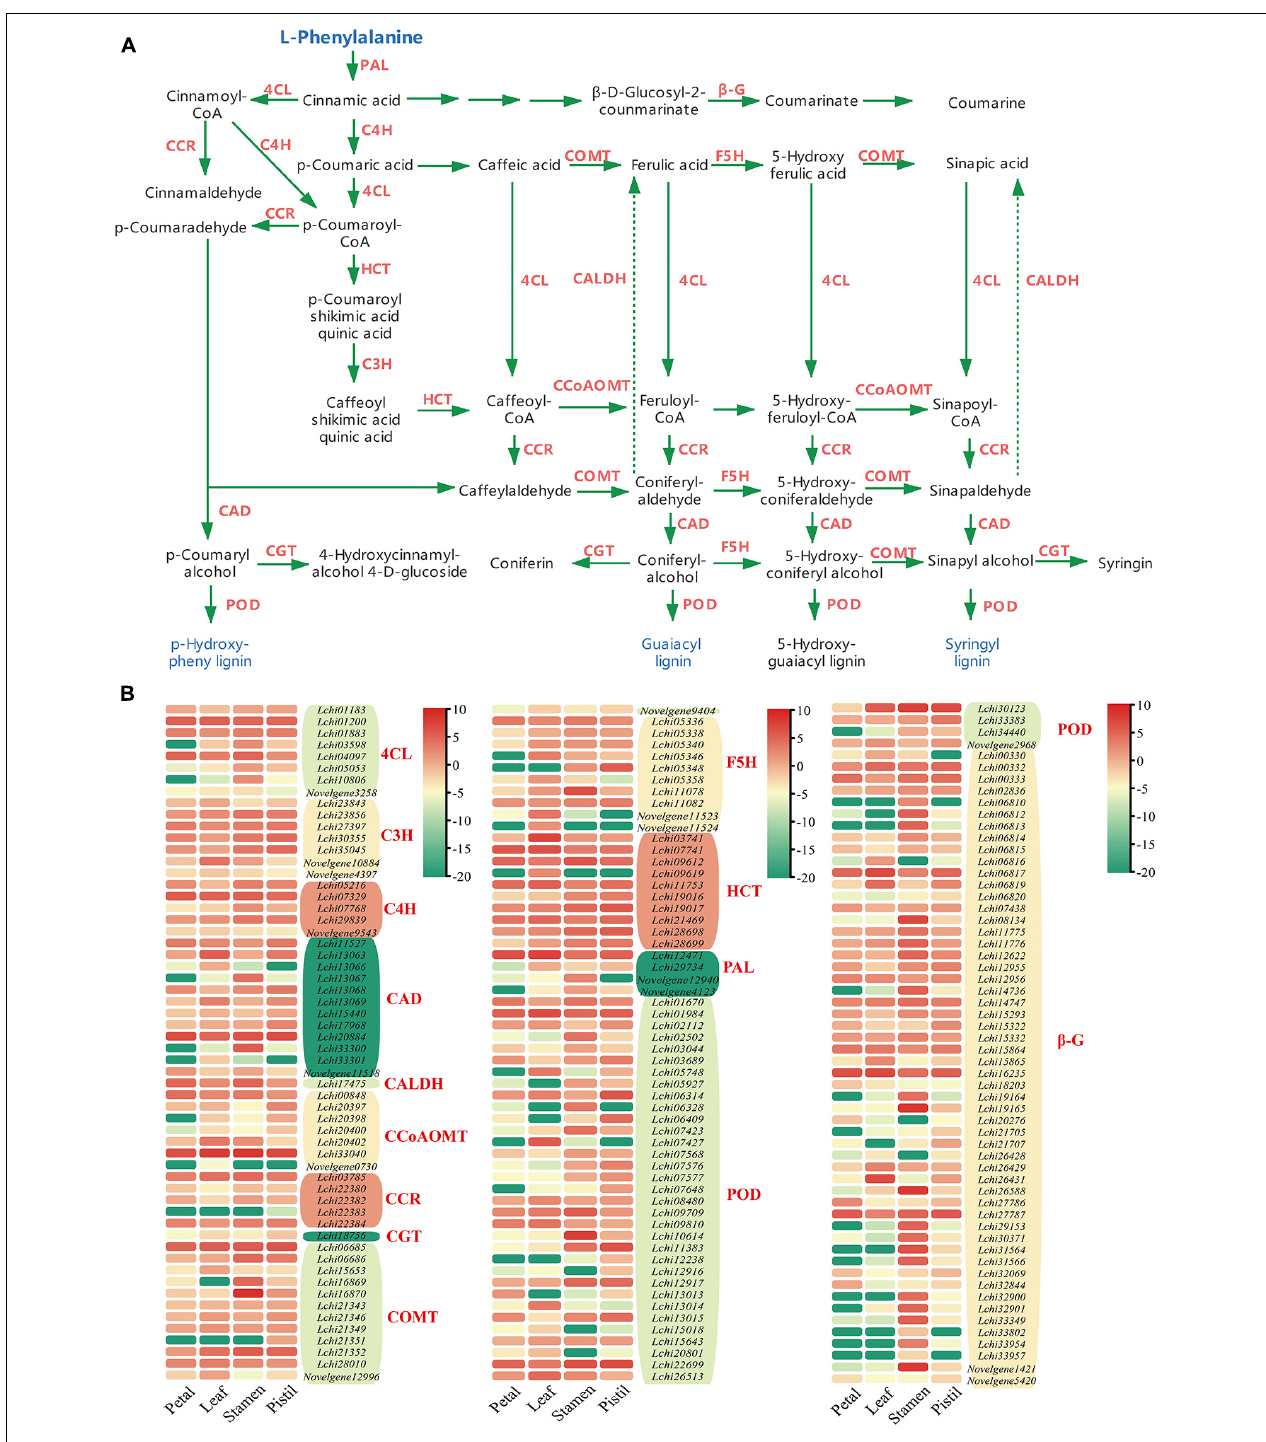
FIGURE 2 | The phenylpropanoid biosynthesis pathway and phenylpropanoid biosynthesis related DEGs in L. chinense . (A) Phenylpropanoid biosynthesis pathway in L. chinense . β -G, beta-glucosidase; 4CL, 4-coumarate-CoA ligase; C4H, cinnamate-4-hydroxylase; C3H, p -coumaroyl ester 3-hydroxylase; CAD, cinnamyl-alcohol dehydrogenase; CALDH, coniferyl-aldehyde dehydrogenase; CCR, cinnamoyl-CoA reductase; CCoAOMT, caffeoyl-CoA O -methyltransferase; CGT, coniferyl-alcohol glucosyltransferase; COMT, caffeic acid 3- O -methyltransferase; F5H, ferulate-5-hydroxylase; HCT, hydroxyl cinnamoyl transferase; PAL, phenylalanine ammonia-lyase; POD, peroxidase. (B) Heat map of DEGs in phenylpropanoid biosynthesis pathway. The log2-transformed FPKM values of DEGs were used to generate the diagram.